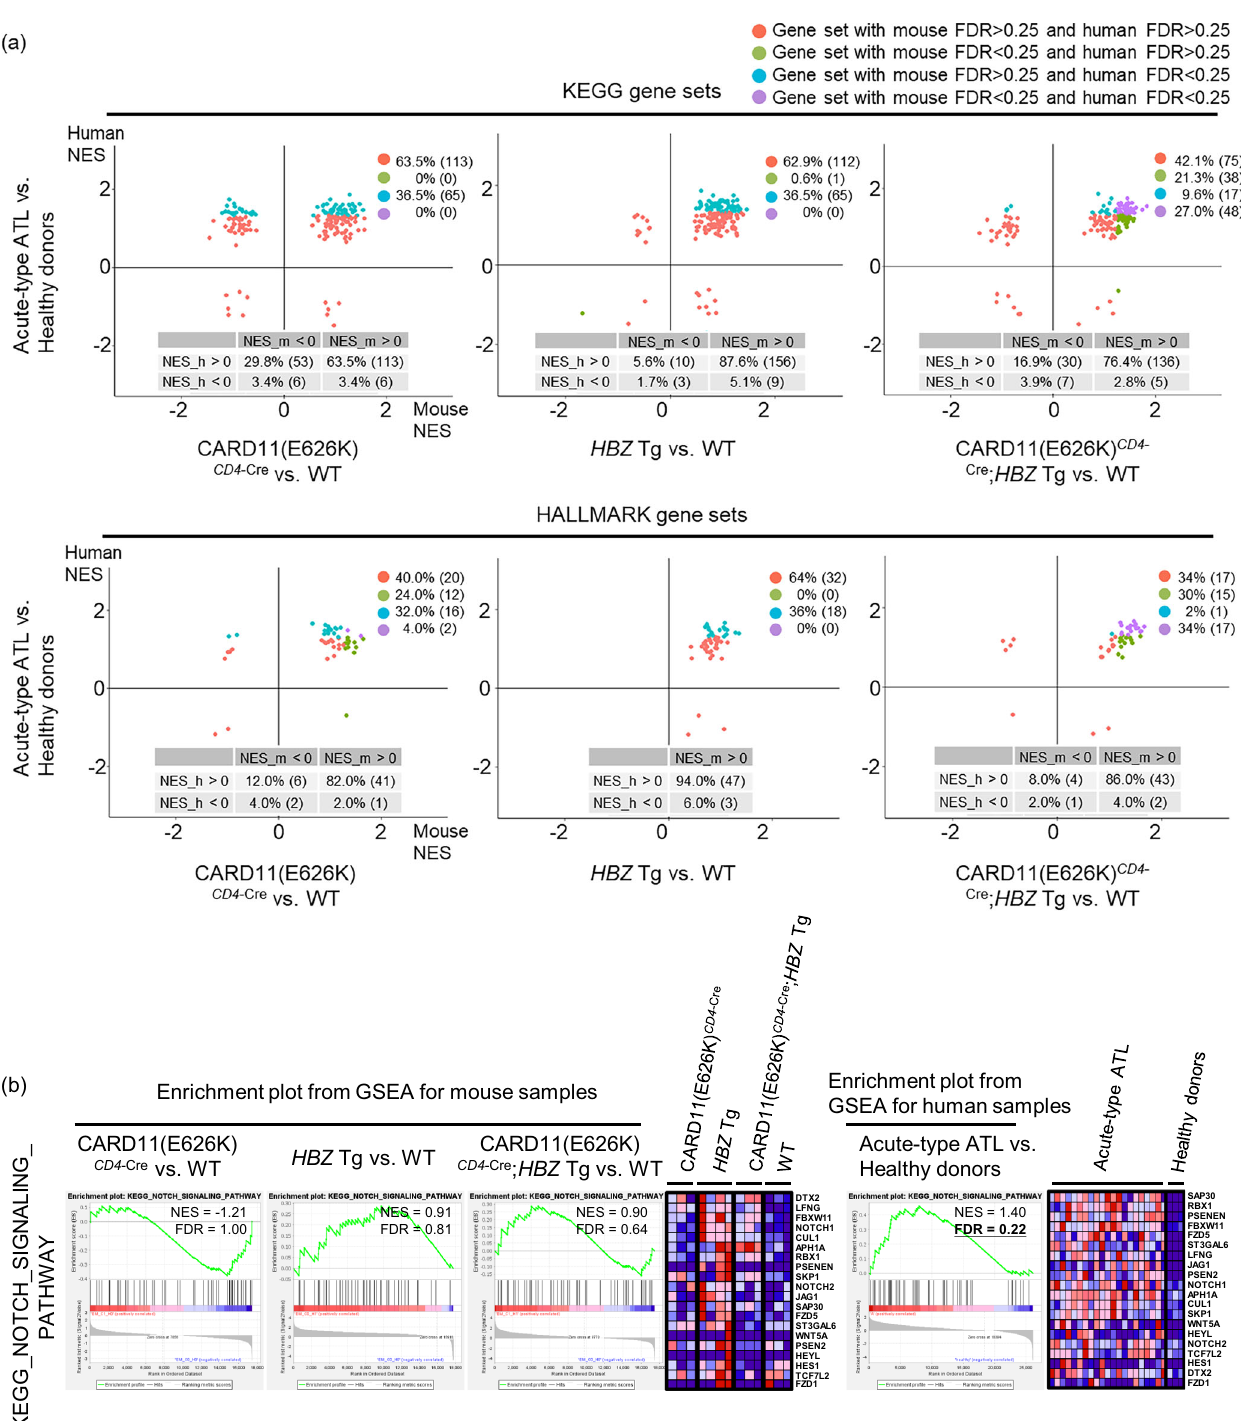
Fig. 8 Gene expression signatures in CARD11(E626K) CD4 -Cre ; HBZ Tg mice recapitulate many of those in human acute-type ATL samples. a Normalized enrichment scores (NESs) in gene set enrichment analysis (GSEA) of the entire KEGG and HALLMARK gene sets show that mice and humans share many of the same enriched gene sets. Each gene set is indicated by a dot and is highlighted in a different color according to the respective false discovery rate (FDR) values for mice and humans, with a common cutoff value 0.25. Each plot legend indicates the frequency (number) of signi fi cant/non-signi fi cant gene sets, based on the common FDR cutoff values in both mice and humans. In the table at the bottom of each plot, the frequency (number) of pathways is indicated, based on the positive/negative values for both mouse NES (NES_m) and human NES (NES_h). b Notch signaling is enriched in the acute-type ATL samples, but not in CARD11(E626K) CD4 -Cre ; HBZ Tg mice. Enrichment plots of the KEGG Notch signaling gene set in mice and humans are shown with their NESs and